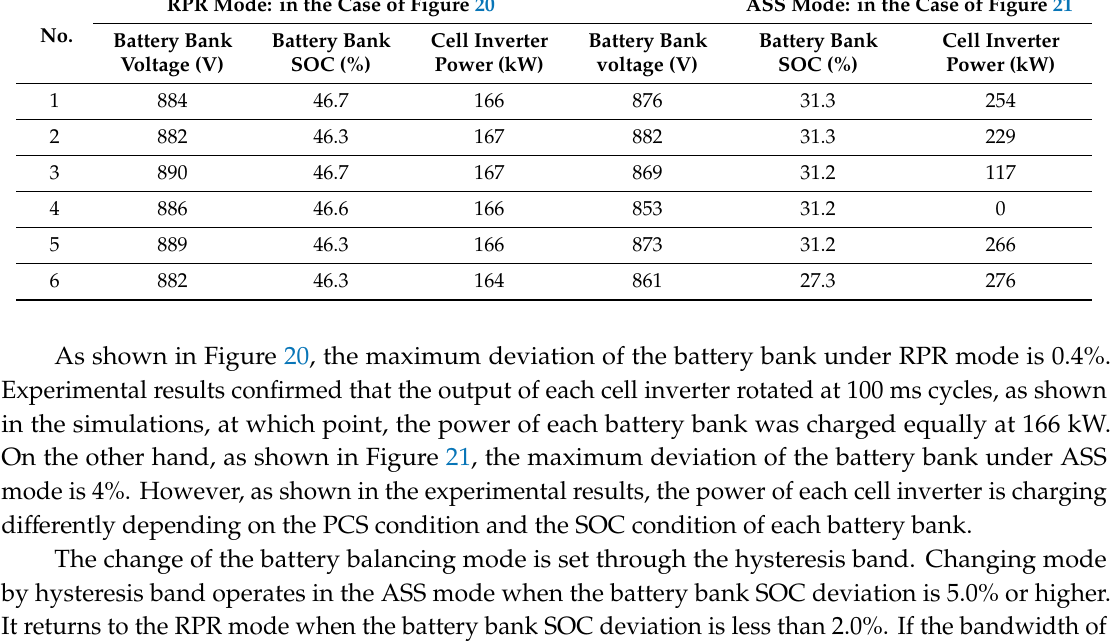
Figure 21. Results of battery balancing according to ASS mode: ( a ) Battery condition for each bank measured on the PMS and ( b ) output waveform of each cell inverter measured by the oscilloscope.